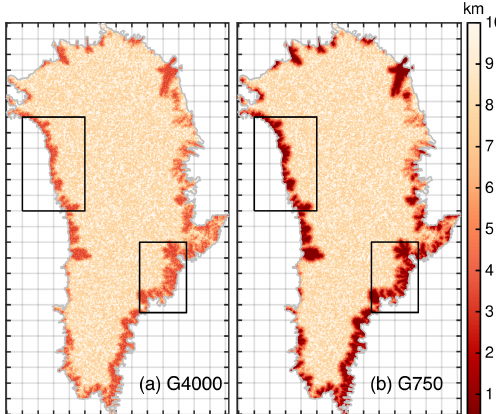
Figure 2. Horizontal mesh resolution (km) used for G4000 (a) and G750 (b) . Data are clipped at 0.5 and 10km. The horizontal res- olution of a triangle is defined by its minimum edge length. The grey line delineates the initial ice domain. Grey grid lines indicate 100km. The black boxes indicate the northwestern and southeast subsets used in following figures.